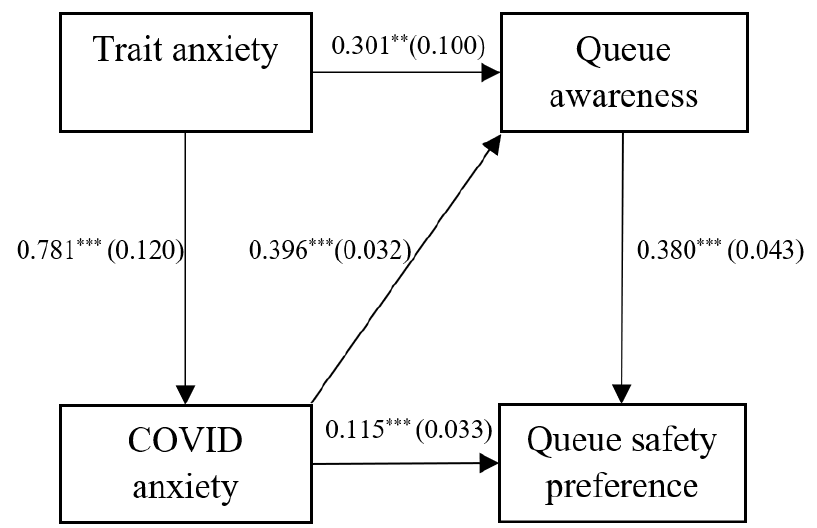
Figure 2. Final path analysis using queue awareness as an observed variable. Unstandardised